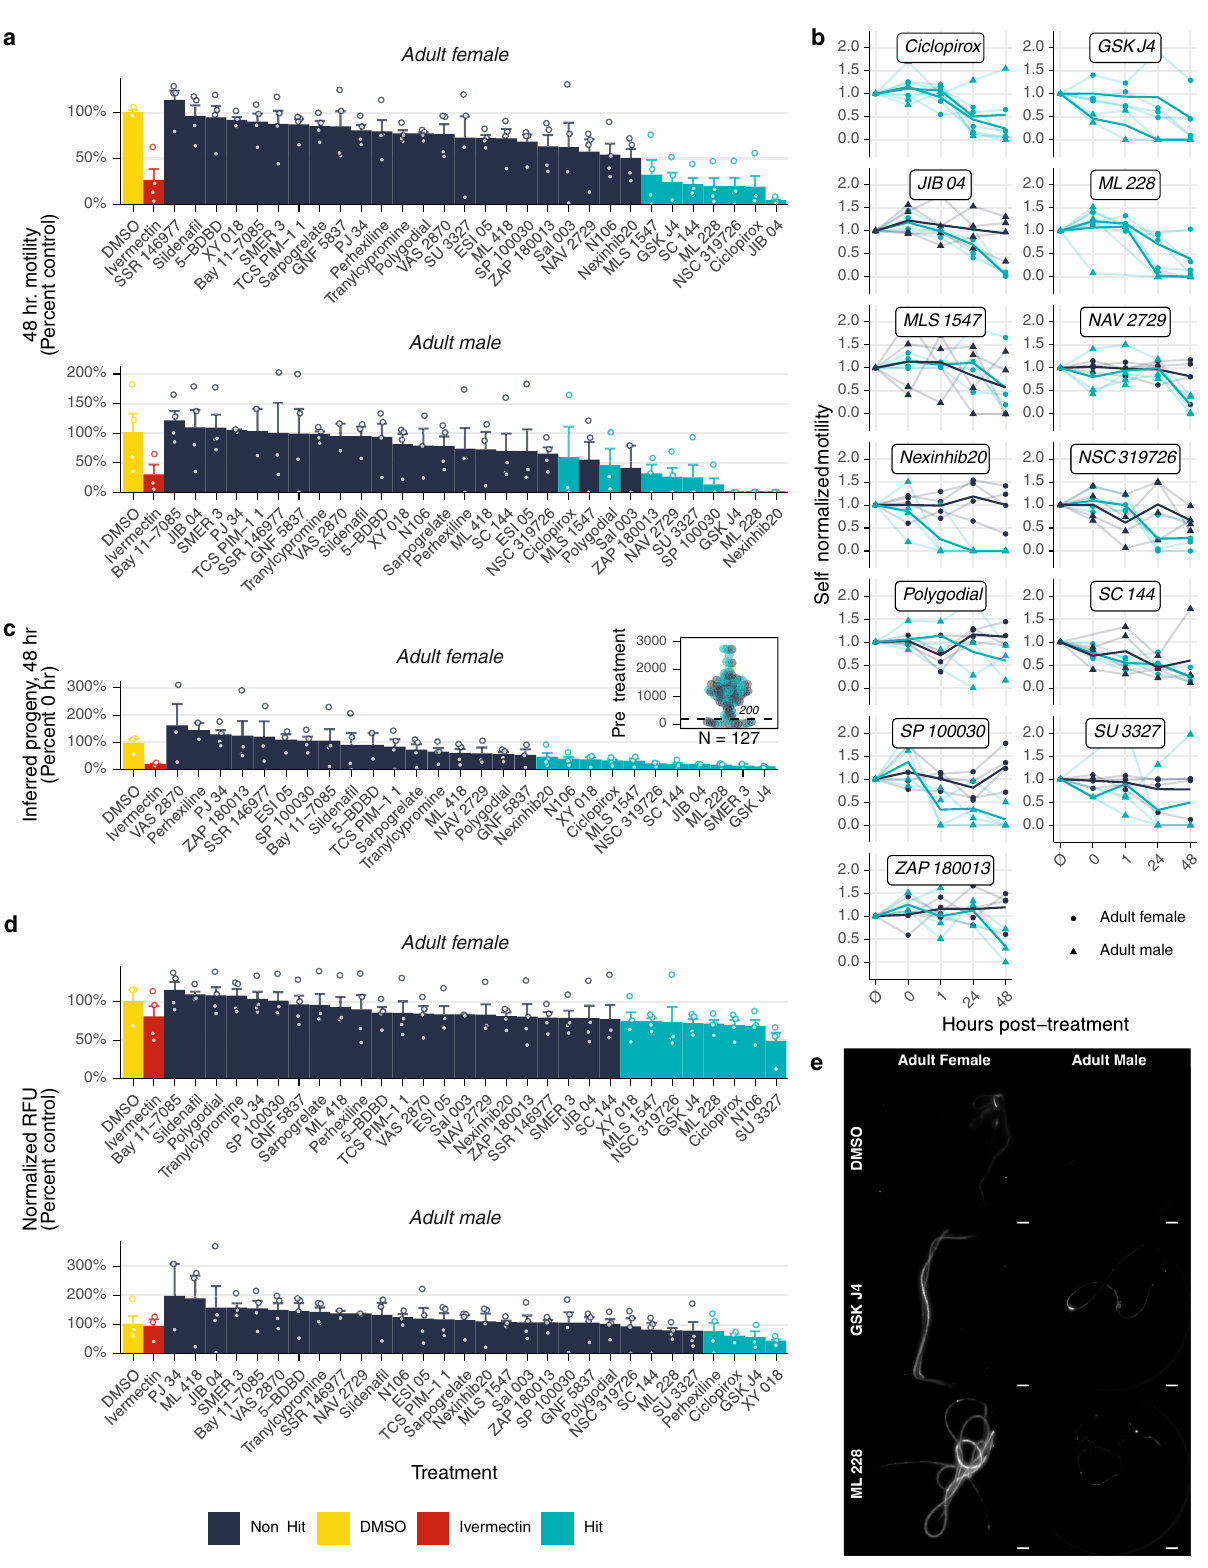
Fig. 6 Secondary screen of adult male and female B. pahangi . a Motility of worms after 48 h post-treatment (hpt). Compounds in light blue are hits, navy blue are not hits. b Individual worm motility over time. Ø = immediately prior to drug addition, 0 = immediately after drug addition. c Progeny released 48 hpt. (Inset) Female worms that released <200 mf after overnight culture in complete media were fi ltered from downstream analysis. d Lactate production after 48 hpt. e Example images of viability-stained adults. Stained worms are dead. Scale bars represent 500 µ m. For all bar charts, each point is an individual worm, columns are the mean of the group, and bars represent the standard error of the